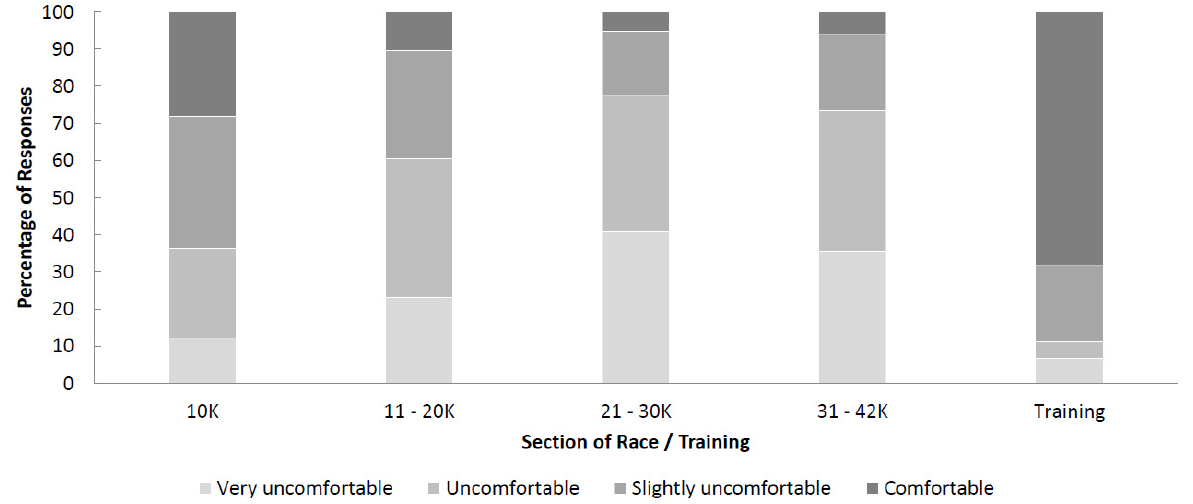
Figure 5. Thermal comfort during 2018 VMLM and a typical training session during winter/spring in the UK in preparation for this event.